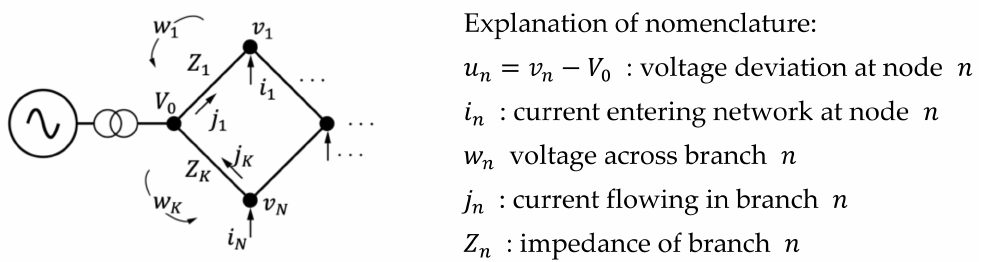
Figure 2. Nomenclature for the nodes and branches of a single